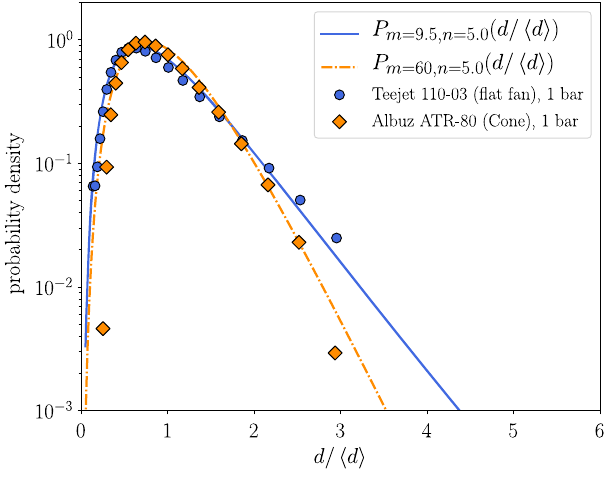
FIG. 10. Comparison of the droplet size distribution of the Teejet 110-03 (flat fan) and Albuz ATR 80 (conical) nozzle at 1.0 bar. The lines indicate the predicted drop-size distributions according to the measured values of m and setting the values n ¼ 5